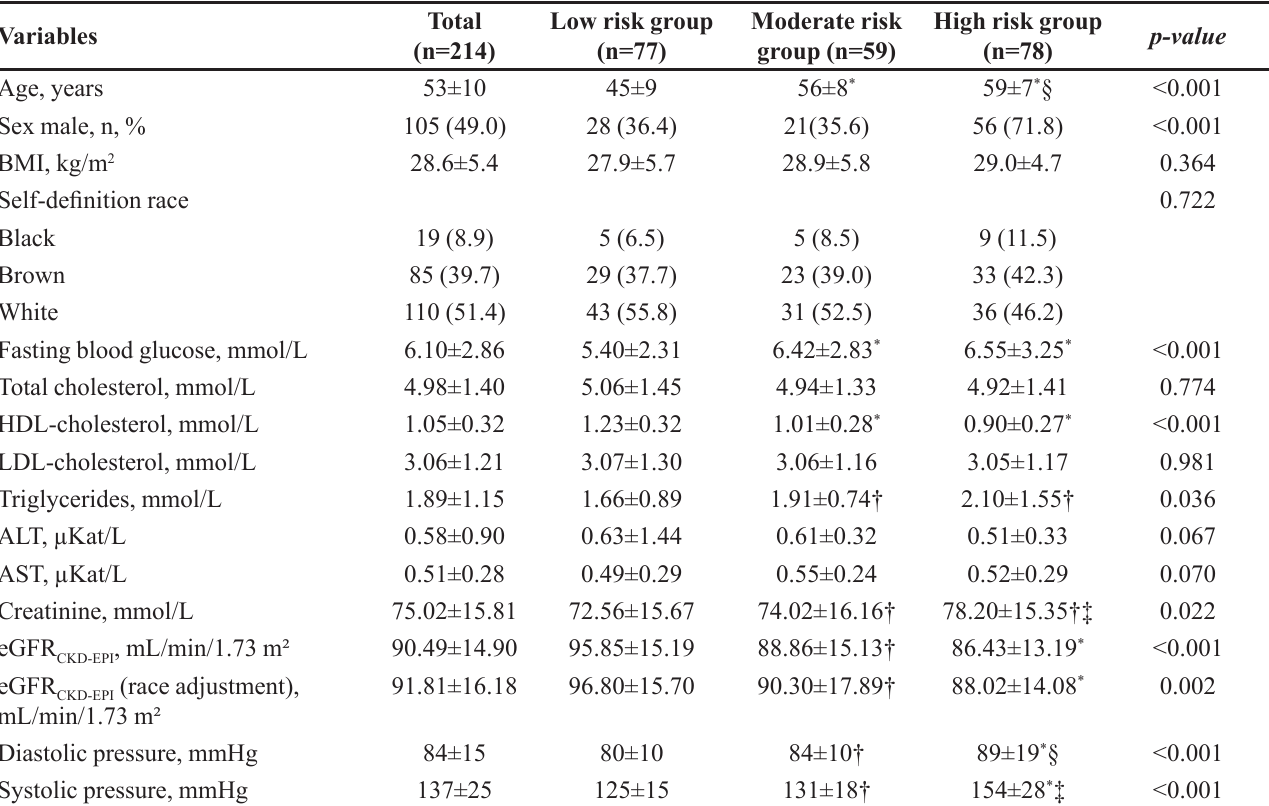
TABLE I - Demographic and clinic data of the different groups of patients, classified according to FRS Variables